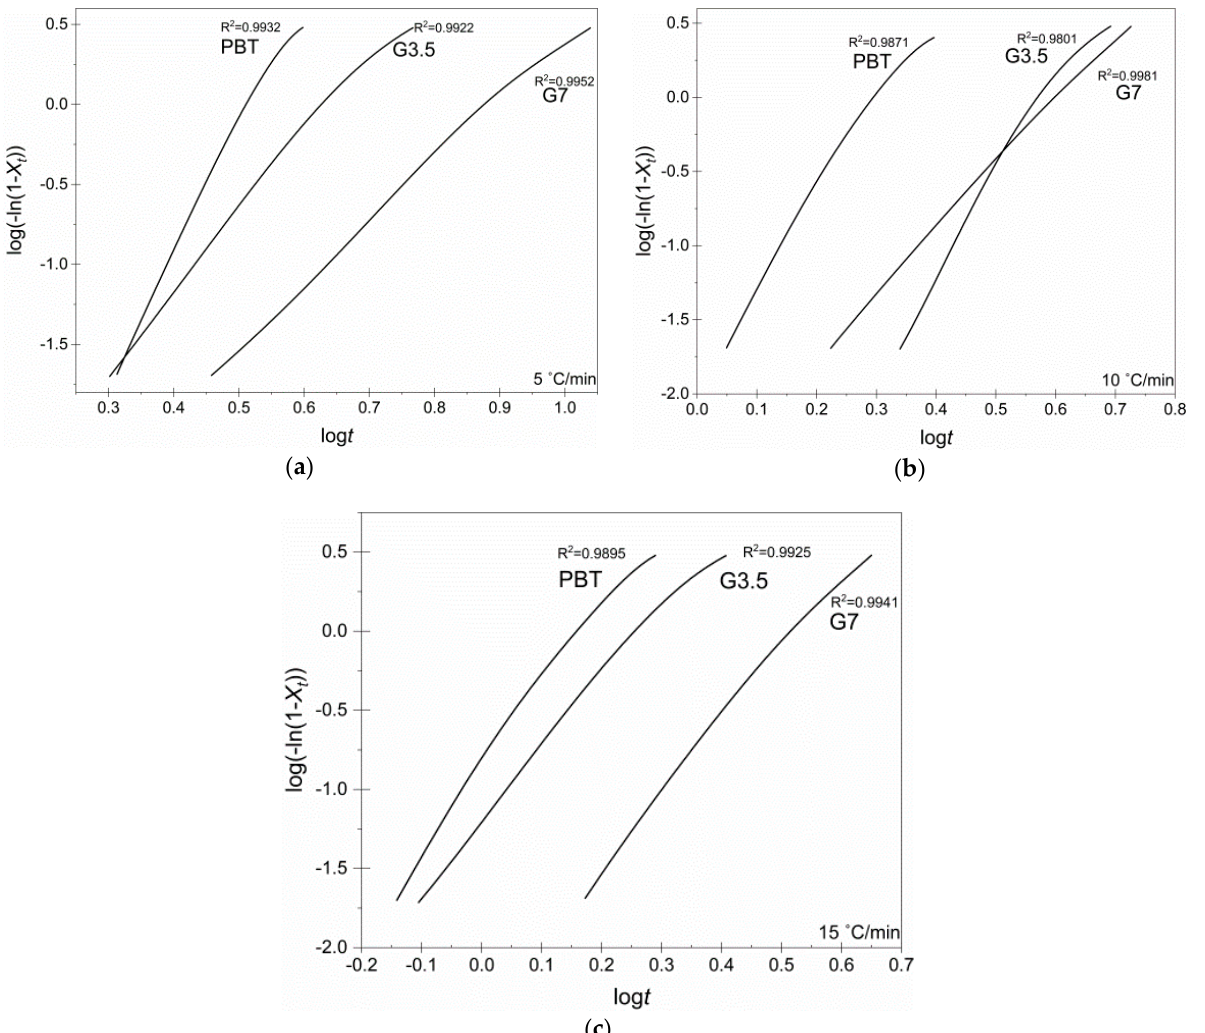
Figure 4. X t vs. t for pure PBT , G3.5 and G7 vitrimers (3 h at 180 °C) at each cooling rate: ( a ) 5 °C/min, ( b ) 10 °C/min and ( c ) 15 °C/min.